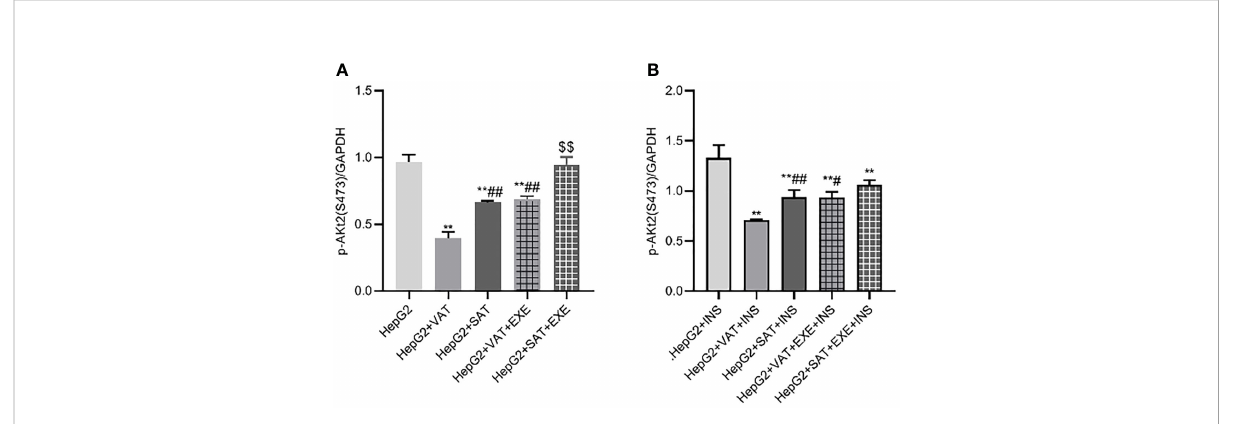
FIGURE 9 The in fl uence of exenatide on the expression of p-AKt2(S473) protein in hepatocytes conducted by different regional adipose tissue. (A) Expression of p-AKt2(S473) protein in HepG2 cells of each group. Data are means ± SEM, n = 3/group, **P < 0.01 vs. HepG2 group; ## P < 0.01 vs. HepG2+VAT group; $$ P < 0.01 vs. HepG2+SAT group. (B) Expression of p-AKt2(S473) protein in HepG2 cells of each group under the action of insulin. Data are means ± SEM, n = 3/group, **P < 0.01 vs. HepG2+INS group; # P < 0.05, ## P < 0.01 vs. HepG2+VAT+INS